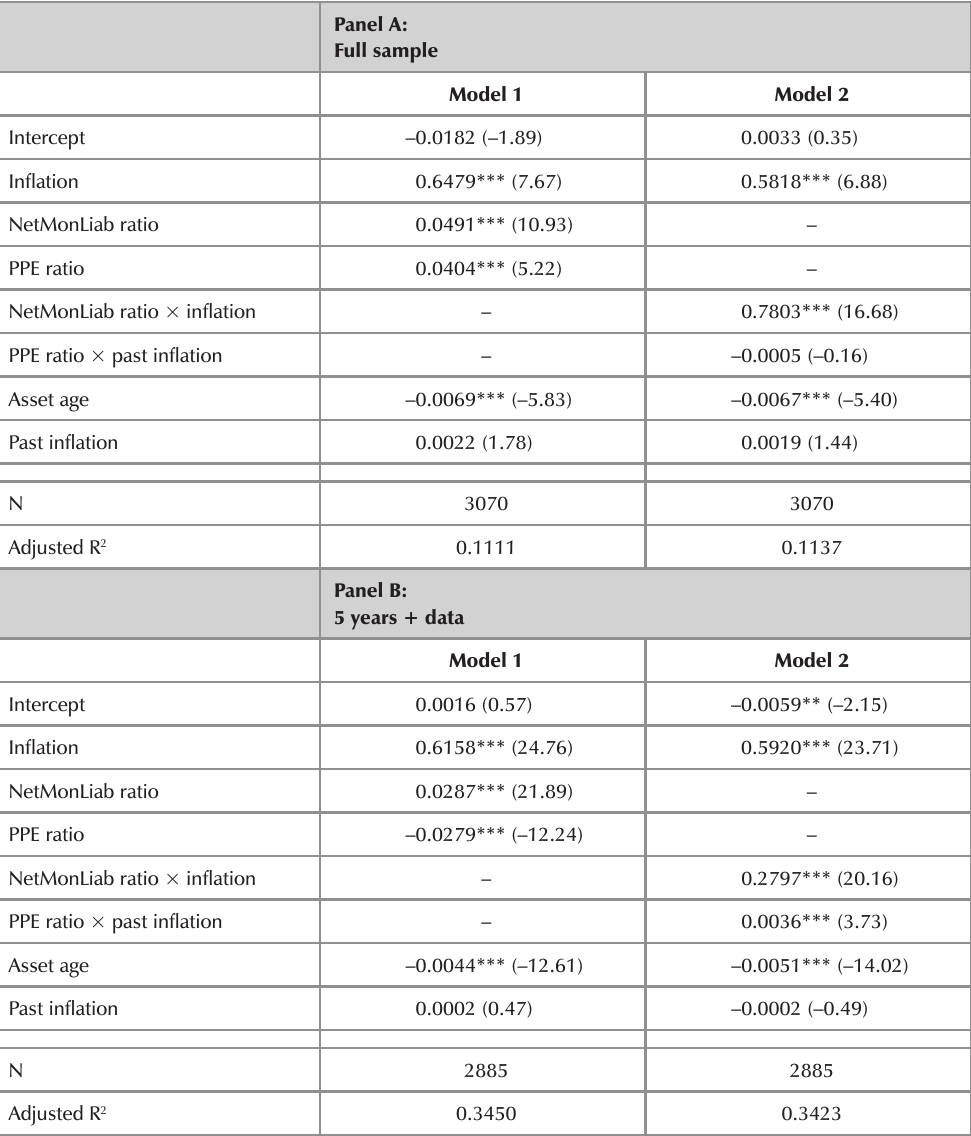
level of gearing and asset